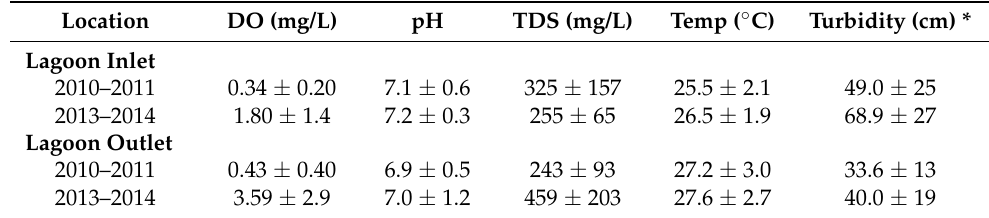
Table 1. Means of physical–chemical parameters monitored at Laguna Cartagena.